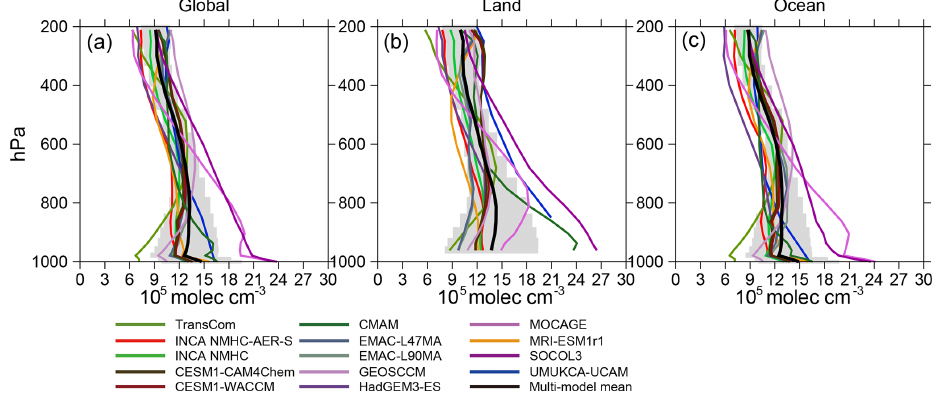
Figure 3. Vertical distributions of [OH] averaged over the globe (a) , land (b) , and ocean (c) for 2000–2010. Color lines represent [OH] from individual model simulations, black lines represent multi-model mean values, and gray shades represent the standard deviations. Table 4. Global mean [OH] averaged over the troposphere and three vertical pressure levels (10 5 moleccm − 3 ) over the years 2000 to 2010. Multi-model means and standard deviations (mean ± SD) are also